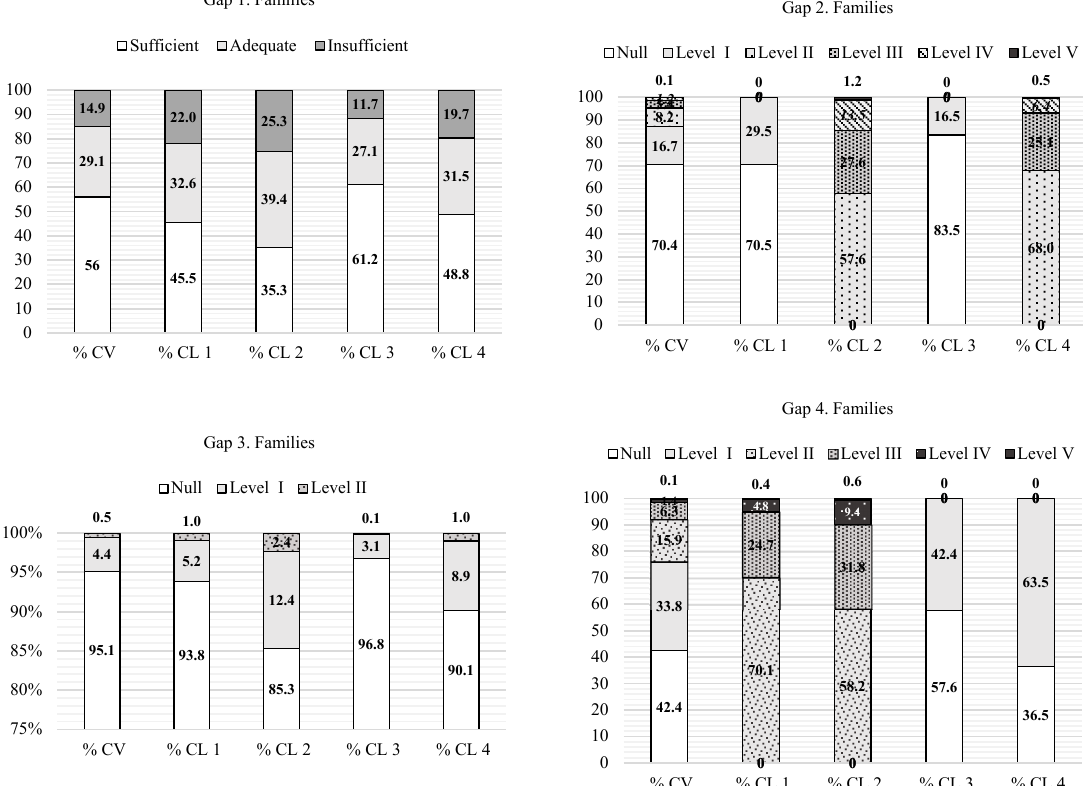
Figure 5. Percentage distribution of each gap in the 4-group cluster solution compared to the total of the